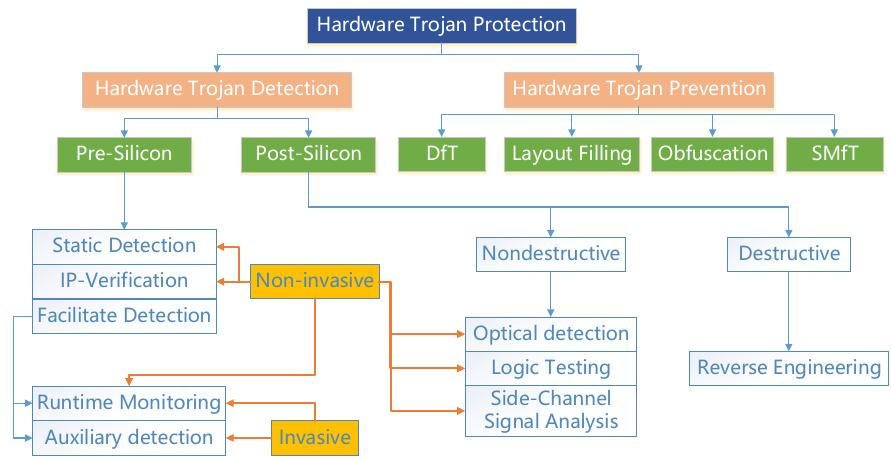
Figure 11. HTs detection techniques